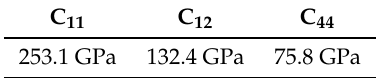
Table 3. Elastic constants of the stiffness tensor C , provided by Xie et al.